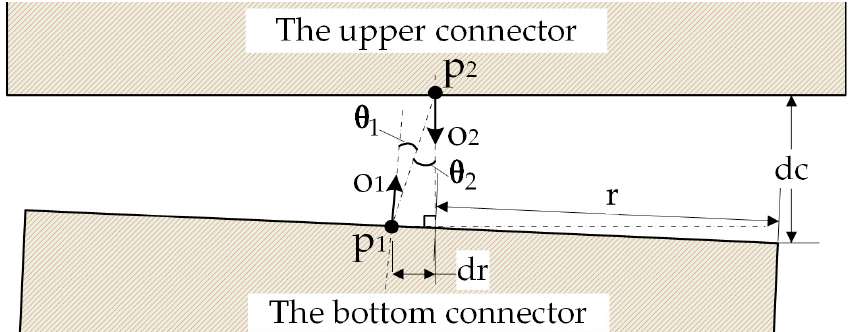
Figure 12. Assembly geometric constraints analysis.